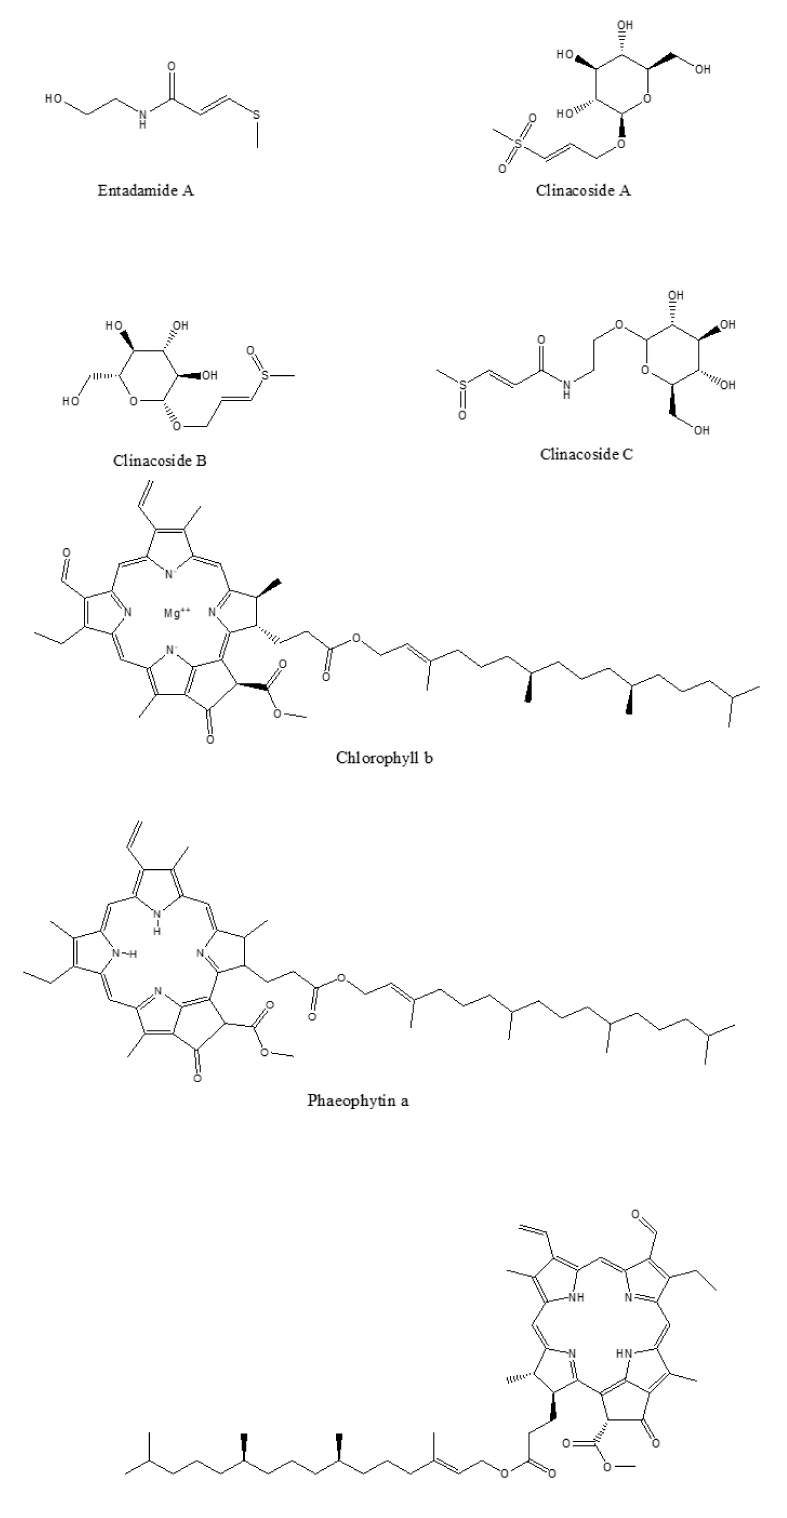
Figure 3. 2D-chemical structure from various phytochemical classes and compounds present in C. nutans leaves (diagram was reconstructed using Chem-Draw ultra-Structure